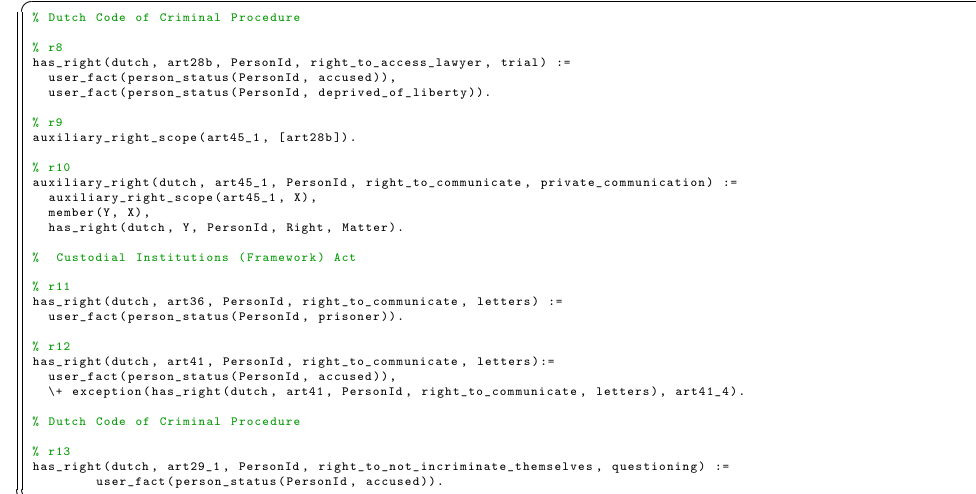
Figure 18. Dutch law transposition in Prolog.